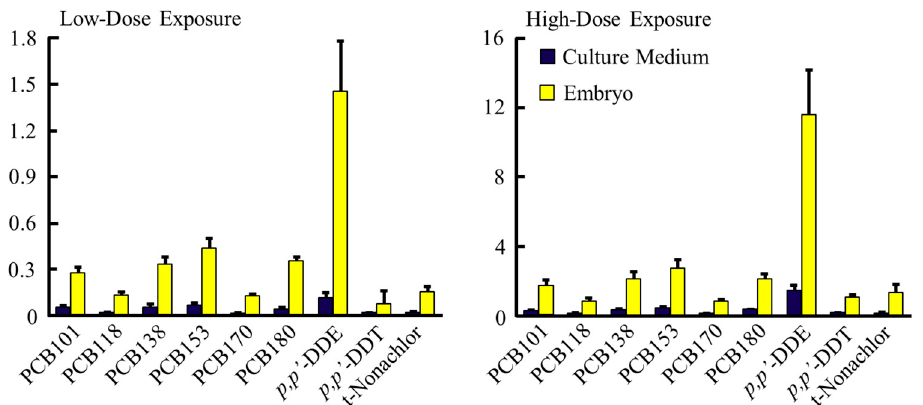
Figure 1. Major congener profiles of organohalogens in the culture medium and embryos with low- and high-dose exposure. E11.5 rat embryos were cultured for 48 h at 38 °C by rotating in 100% rat serum. Each column represents the mean ± S.D. (vertical bars) for four embryos. PCB 101, 2,2 ′ ,4,5,5 ′ - pentachlorobiphenyl; PCB 118, 2,3 ′ ,4,4 ′ ,5-pentachlorobiphenyl; PCB 138, 2,2 ′ ,3,4,4 ′ ,5 ′ -hexachlorobi- phenyl; PCB 153, 2,2 ′ ,4,4 ′ ,5,5 ′ -hexachlorobiphenyl; PCB 170, 2,2 ′ ,3,3 ′ ,4,4 ′ ,5-heptachlorobiphenyl; PCB 180, 2,2 ′ ,3,4,4 ′ ,5,5 ′ -heptachlorobiphenyl; p,p ′ - DDE, 1,1-bis(4-chlorophenyl)-2,2-dichloroeth- ylene; p,p ′ -DDT, 1,1-bis(4-chlorophenyl)-2,2,2-trichloroethane; t-Nonachlor, trans-nonachlor.